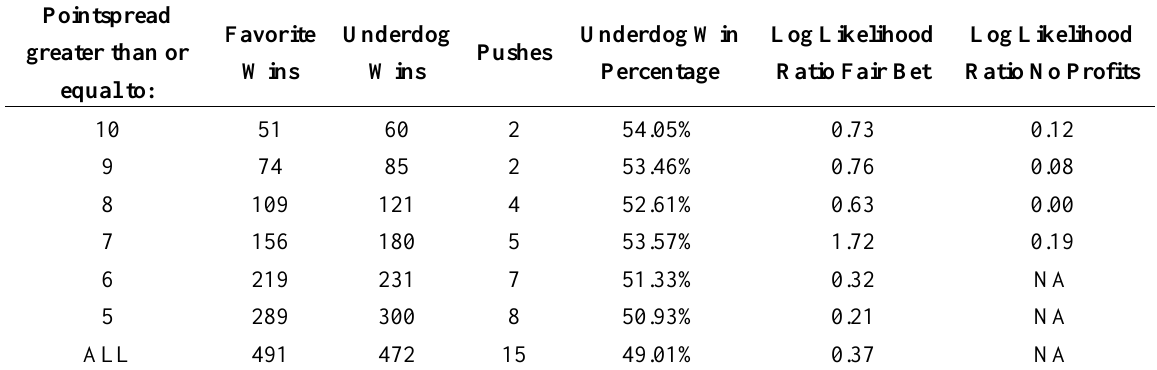
Table 3. Betting Simulation Results—WNBA—Home Favorites.